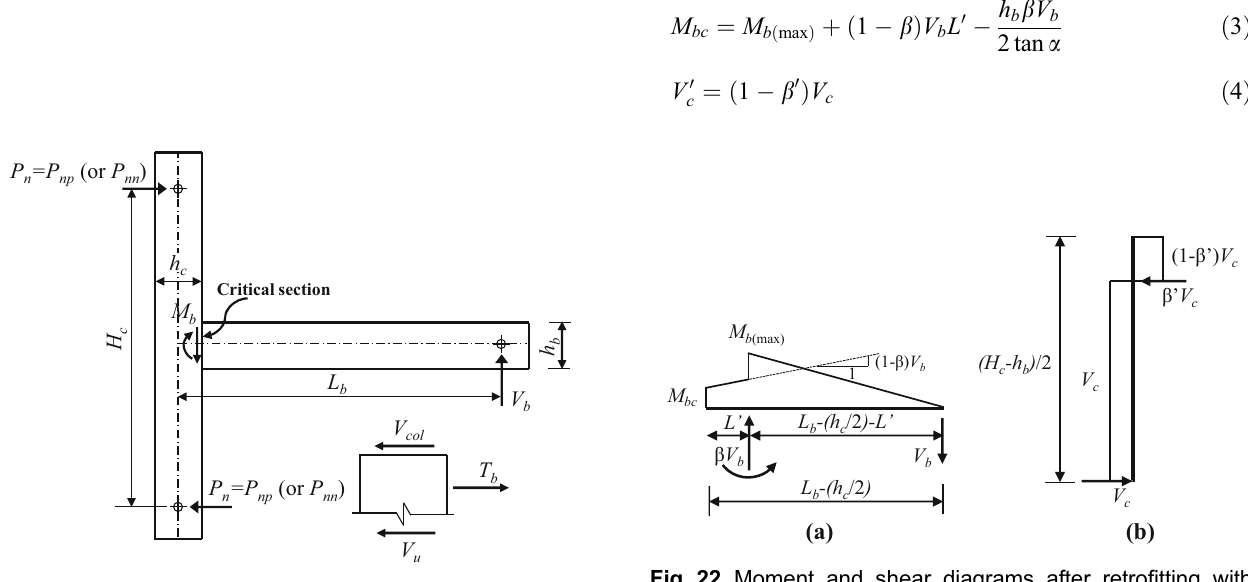
Fig. 22 Moment and shear diagrams after retrofitting with haunch elements (Chen 2006): a moment diagram in the beam and b shear diagram in the column.